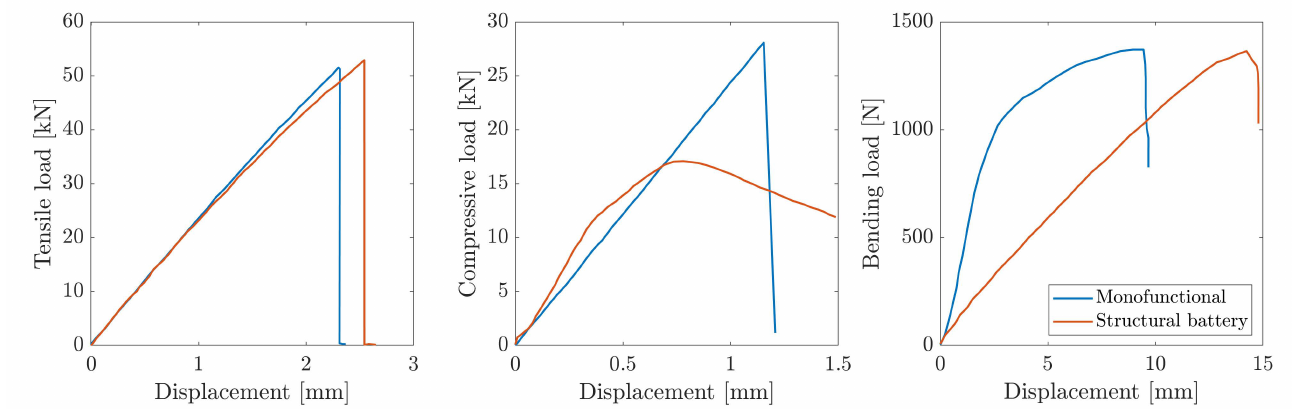
Figure 8. Effect of cell embeddings in sandwich panel mechanical performance [38].